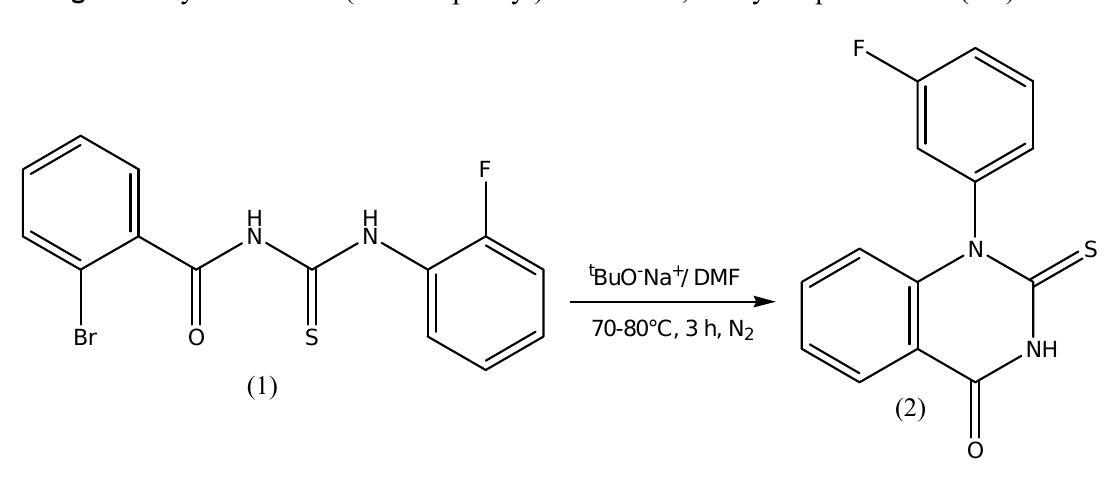
Figure 1. Synthesis of 1-(3-fluorophenyl)-2-thioxo-2,3-dihydroquinazolin-4(1 H